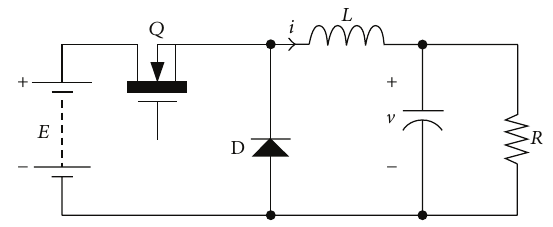
Figure 1: Semiconductor realization of the DC/DC buck converter.